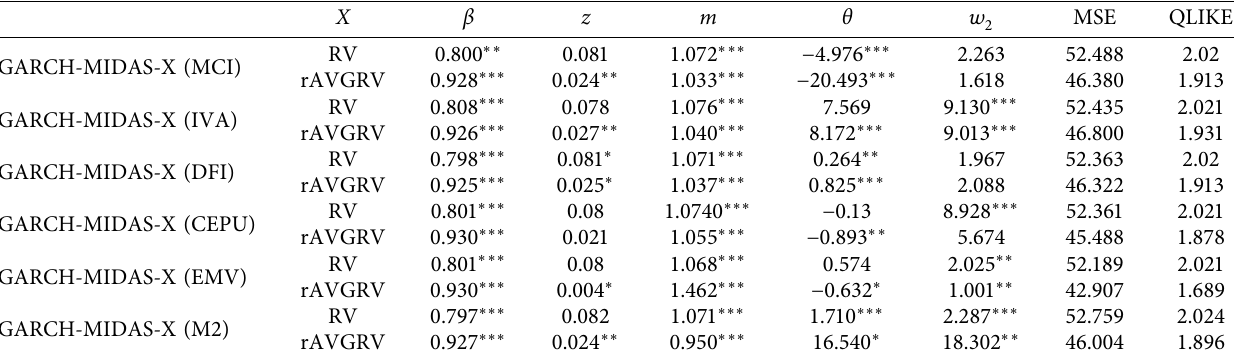
Table 7: Estimation results of GARCH-MIDAS-X ( K �